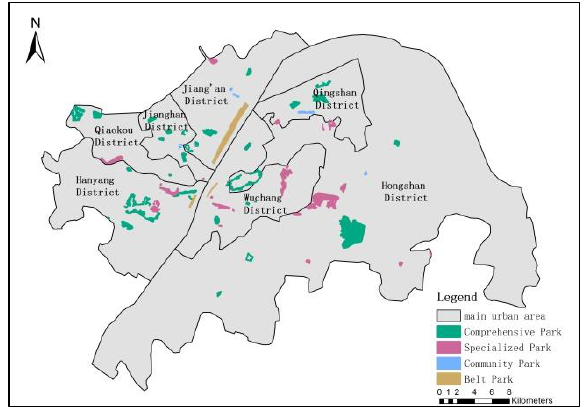
Figure 3. Distribution of green space in various types of parks in Wuhan city.